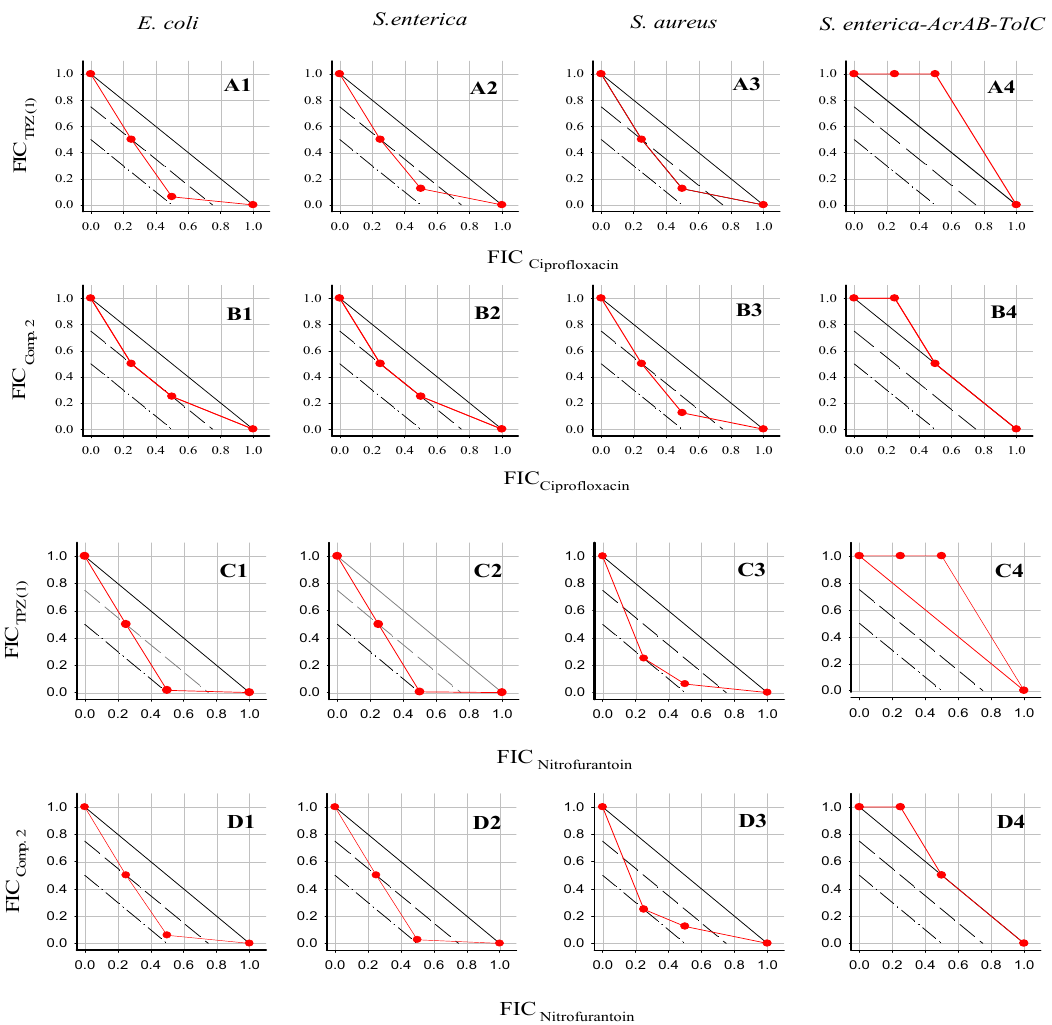
Figure 2. Isobolograms of combinations of TPZ ( 1 ) and the lead compound 2 versus ciprofloxacin and nitrofurantoin expressed in terms of their fractional inhibition concentration (FIC) values against Gram-negative E. coli ( A1 – D1 ) and S. enterica ( A2 – D2 ) strains, the Gram-positive S. aureus strain ( A3 – D3 ), and the S. enterica strain over-expressing AcrAB-TolC ( A4 – D4 ). The straight lines connecting the end points of the y- and x-axis of the FICs of TPZs and antibiotics, respectively, represent total synergistic e ff ect (dot-dashed line), partial synergistic (dashed line) and additive (non-interactive) e ff ect (solid line). All experiments were performed in triplicate on at least two di ff erent occasions. Weak partial synergistic and virtually additive e ff ects (FICI ~0.75–0.77) were defined for the